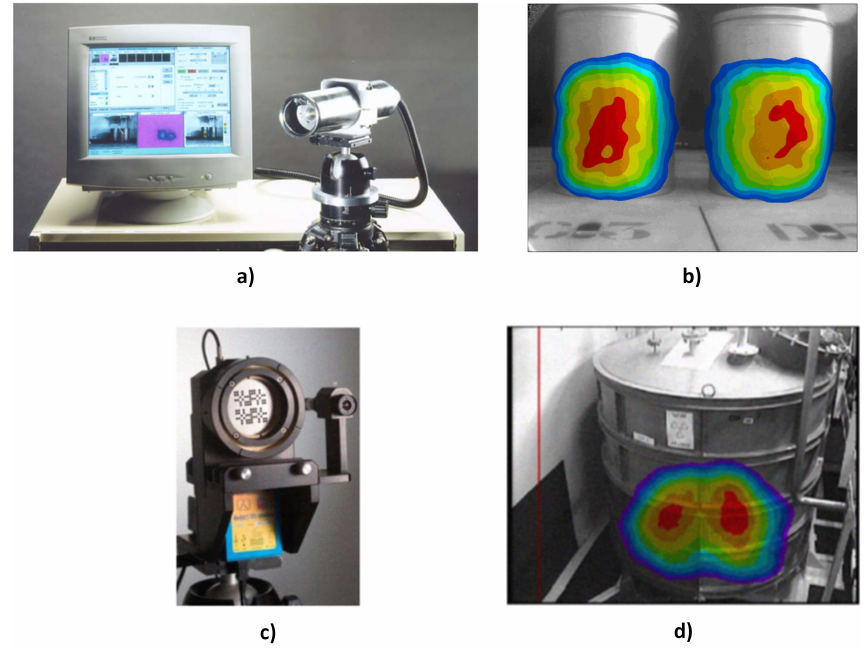
Figure 1. ( a ) CARTOGAM imaging system. The detector head beside the PC is mounted on a tripod [12]. ( b ) Superimposed radiation and visual images from the CARTOGAM [13]. ( c ) GAMPIX gamma camera (small visual camera attached on the left). ( d ) Superimposed radiation and visual images from the GAMPIX camera